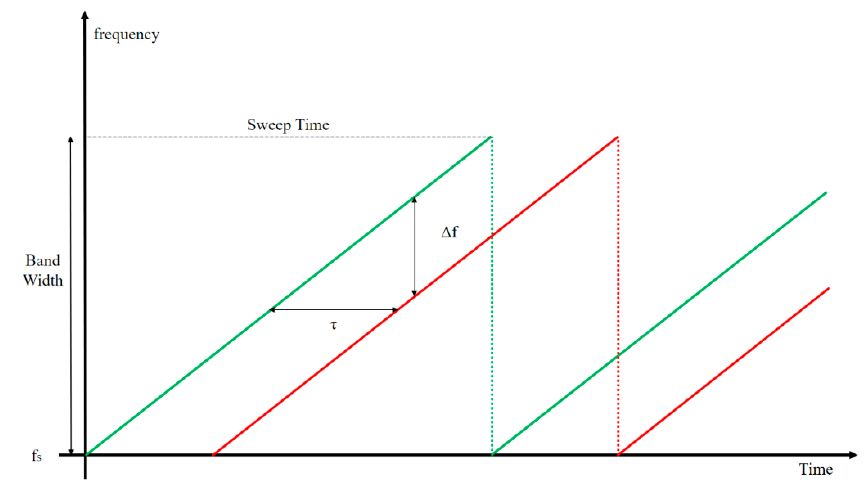
Figure 1. Transmit and receive FMCW RADAR signals .